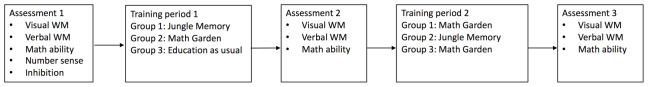
Assessment and treatment procedures.